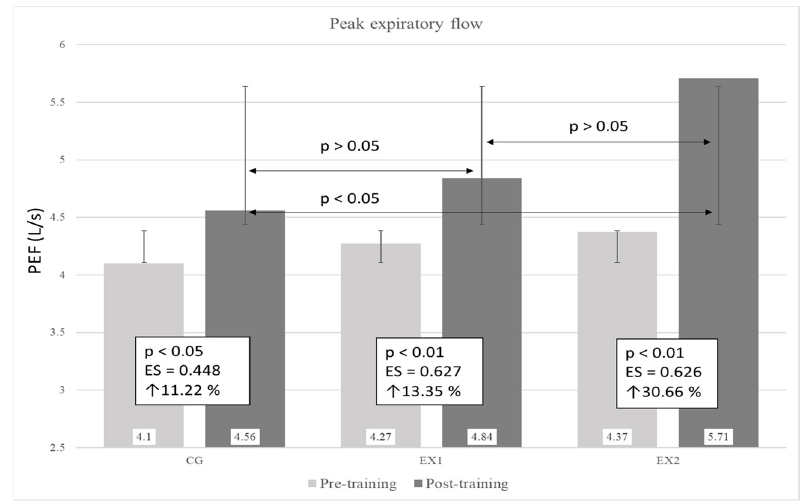
Figure 4. Peak expiratory flow.